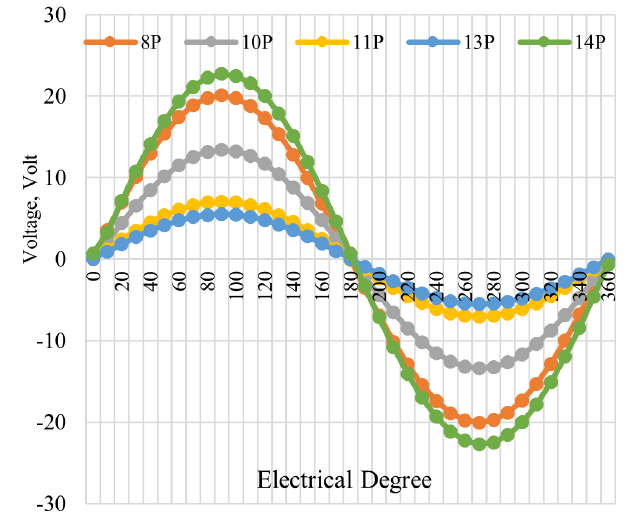
Figure 9. No-load back-EMF of different